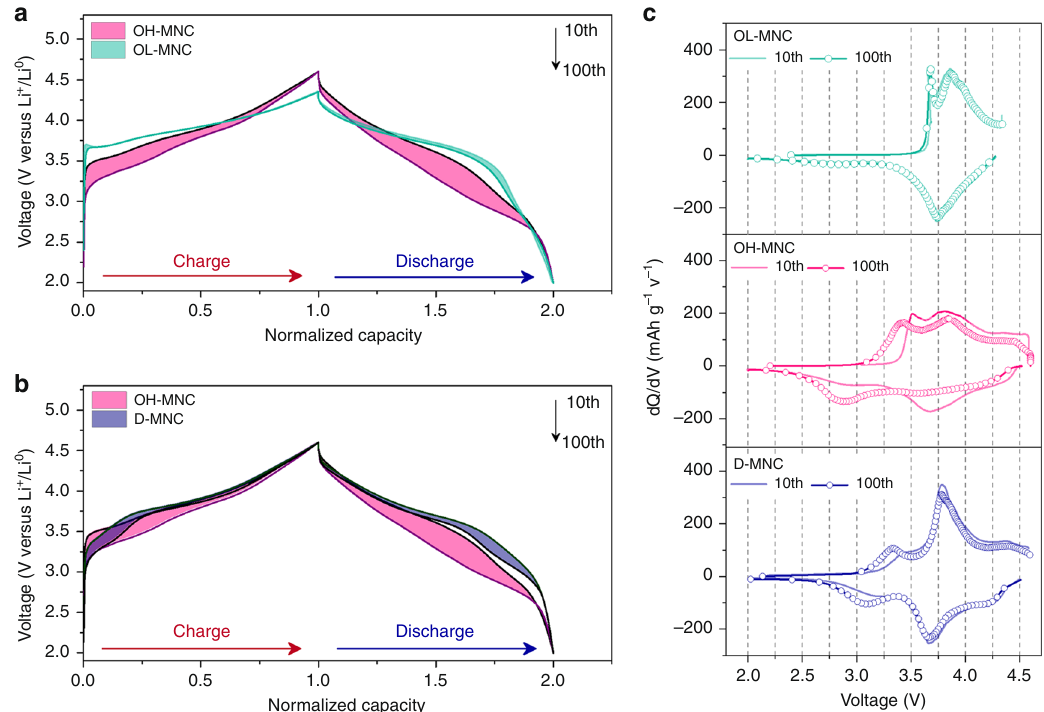
Fig. 1 Cycle behaviuor of O-MNC and D-MNC with a view towards voltage decay. Normalized voltage pro fi le variation for O-MNC and D-MNC from 10th to 100th cycles; Voltage pro fi le variation of a O-MNC in the 2.00 – 4.35 V and 2.00 – 4.60 V (vs. Li-metal) potential region. b O-MNC and D-MNC in the 2.00 – 4.60 V (vs. Li-metal) potential region; 0.5 C-rate charge 1.0 C-rate discharge condition. The capacity normalization was performed by taking the maximum capacity in the corresponding cycle as unity. c dQ/dV plots for the O-MNC and D-MNC obtained from voltage pro fi les in a ,